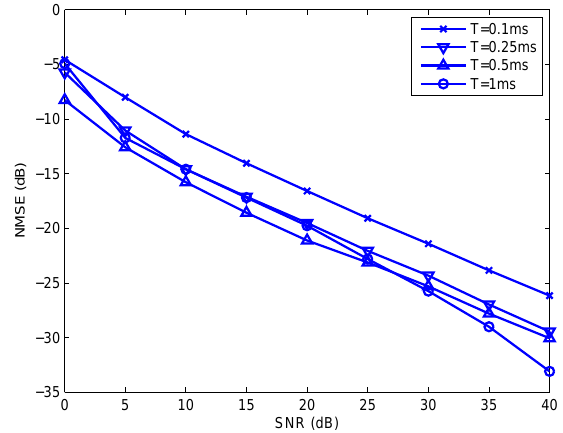
Figure 8. NMSE of the proposed 1.5-bit FM demodulator when T equals to 0.1, 0.25, 0.5 and 1 ms, respectively.